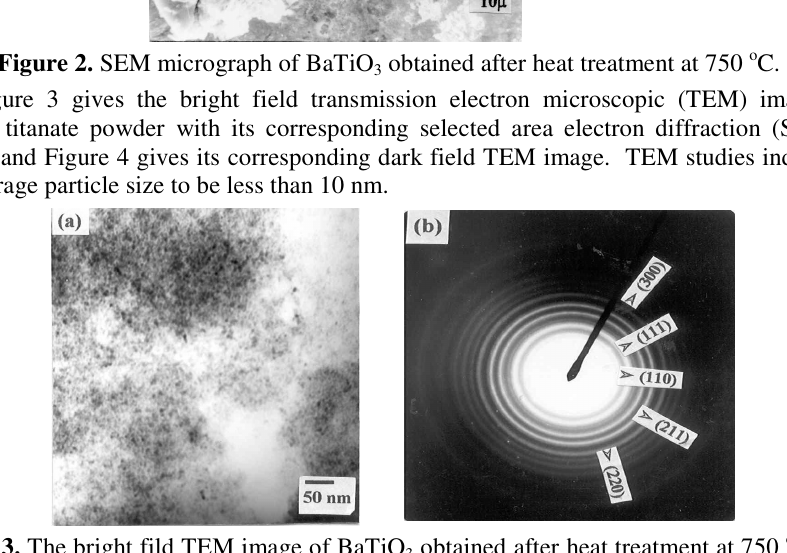
Figure 2. SEM micrograph of BaTiO